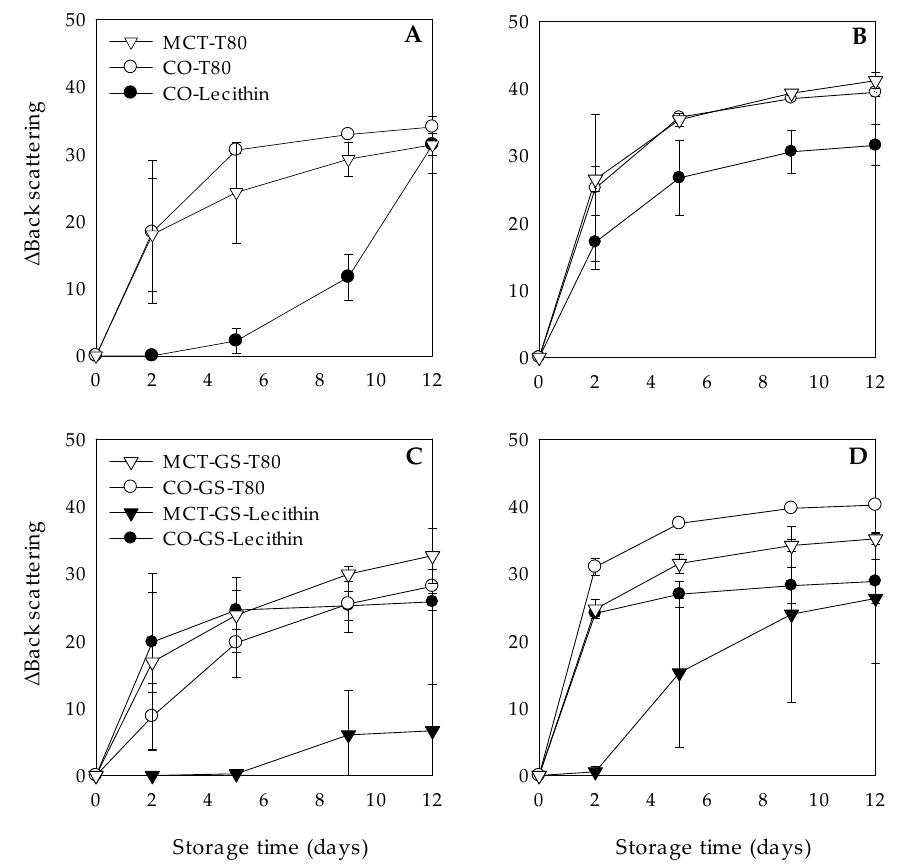
Figure 3. Clarification, expressed as variation of back scattering ( ∆ BS), at 25 ◦ C ( A , C ) and 35 ◦ C ( B , D ) during 12 days of dark storage of chlorophyllin-loaded W1/O/W2 emulsions formulated with different lipid phases consisting on medium chain triglyceride (MCT) or corn oil (CO) and without ( A , B ) or with ( C , D ) glyceryl stearate (GS) as well as different hydrophilic emulsifiers (Tween 80 (T80) or Lecithin).